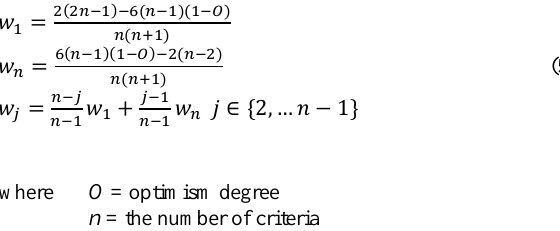
Figure 2. Aggregated seismic vulnerability degree for five randomly selected statistical